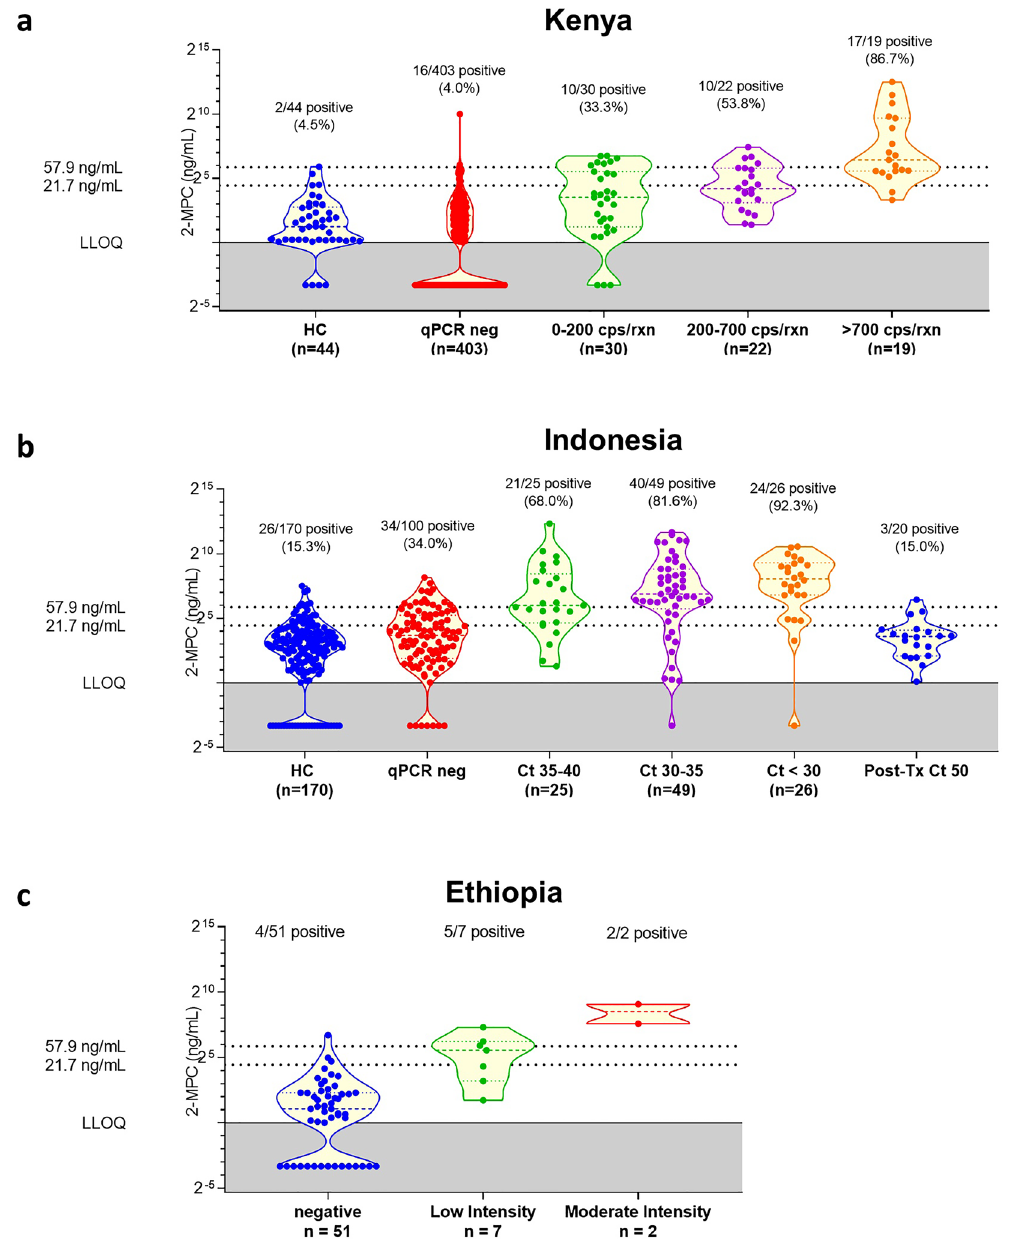
Figure 4. Violin plots of the quantitative values obtained in the different populations, binned according to infection intensity (either qPCR or